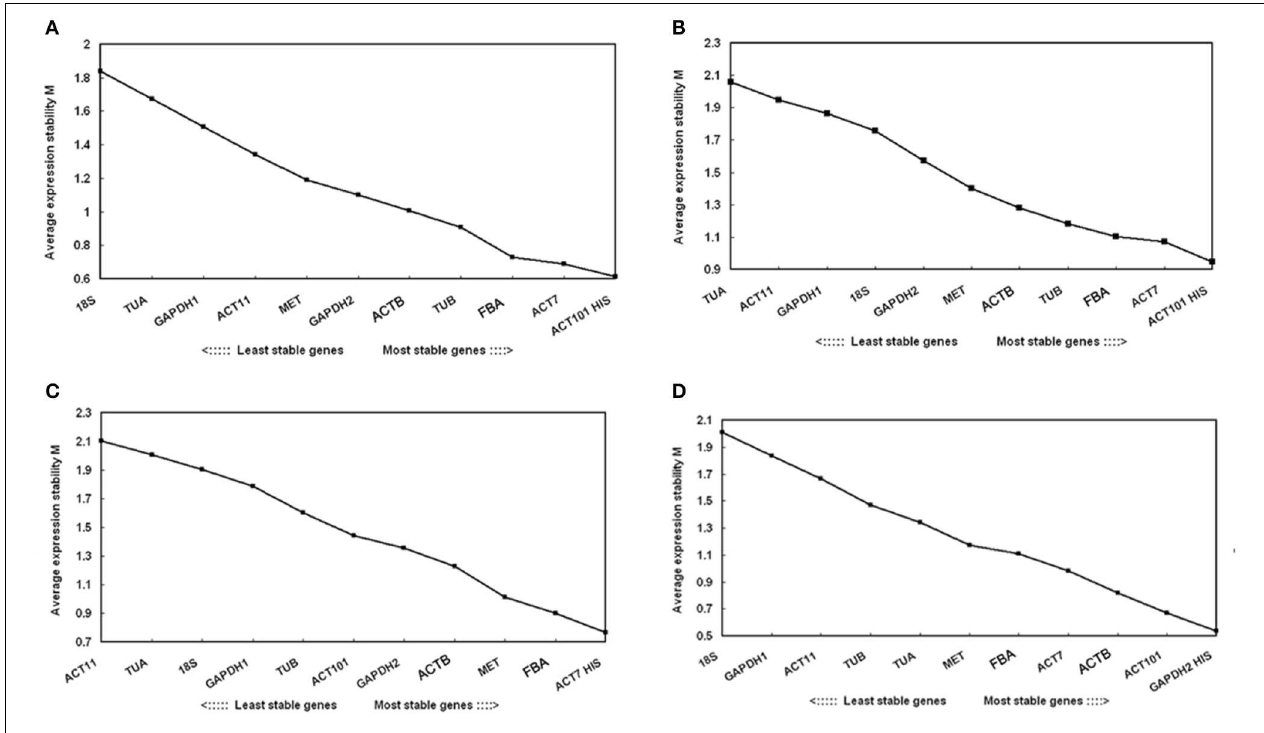
samples and each abiotic stress samples. The least stable genes were on the left and the most stable genes on the right. (A) All tested samples (B) Drought stress (C) Cold stress (D) Salt